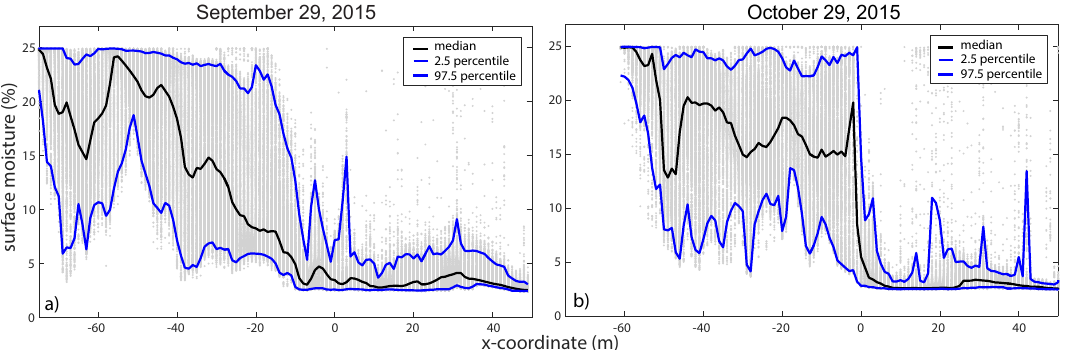
Figure 8. All surface moisture values (gray dots) from all the TLS surveys per day, plotted against their x -coordinate. ( a ) contains 19 surveys measured on 29 September; ( b ) contains 22 surveys measured on 29 October. For both panels, the median (black line) and 2.5 and 97.5 percentile (blue lines) are plotted.